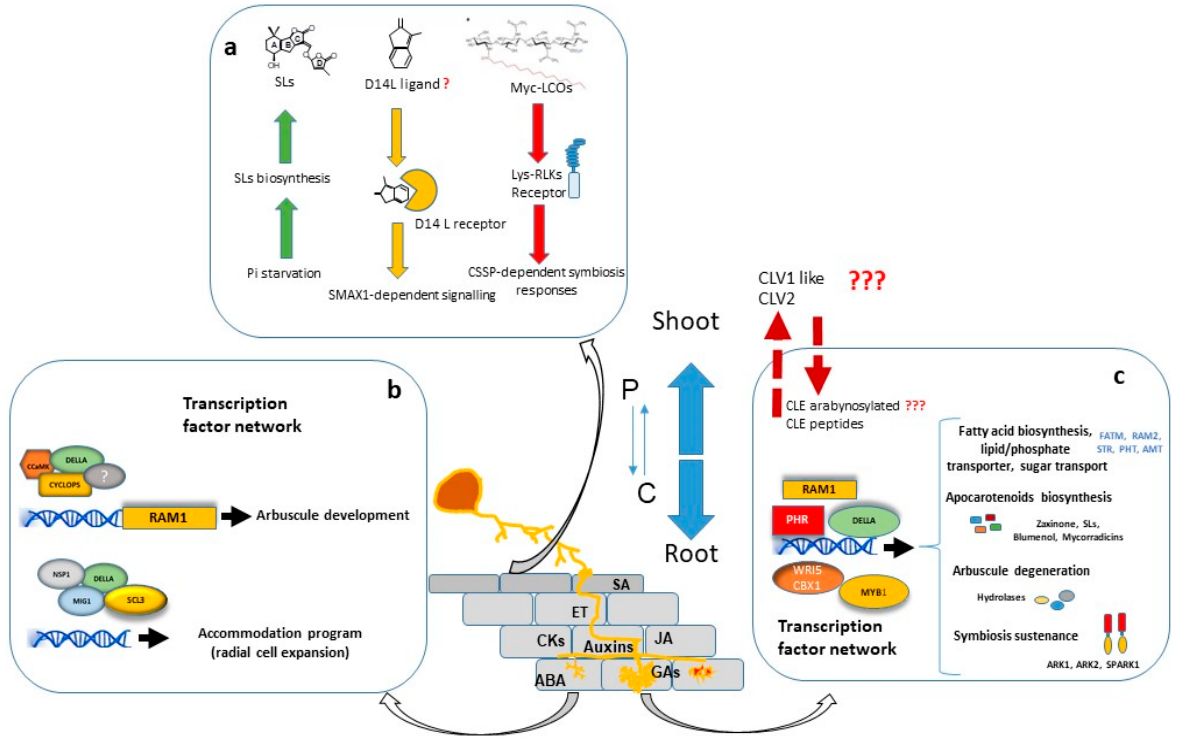
Figure 1. Development of the arbuscular mycorrhizal (AM) symbiosis and its molecular regulation at different stages. AM symbiosis facilitates mutual nutritional benefits: the plant provides carbon (C) to AM fungi in form of carbohydrates and fatty acids, while AM fungi provide minerals, mainly inorganic phosphate (Pi) and nitrogen to the plant. The availability of the different nutrients is a key factor determining the establishment and development of the interaction. AM symbiosis alters plant hormonal homeostasis, and phytohormones play a key regulatory role in the establishment and functioning of the AM symbiosis at different levels: regulating physiology and growth, as well as defense and stress adaptation in AM plants, and participating in the formation and turnover of AM structures. At initial stages ( a ), Strigolactones (SLs), secreted from host roots under Pi starvation, induce fungal spore germination and hyphal branching, facilitating the contact of the fungal hypha with the root and the formation of the hyphopodium. In response to AM perception, a complex of D14L receptor with a yet unknown D14L ligand is proposed to promote the degradation of SMAX1 and the downstream activation of target genes, including symbiosis-related and SL synthesis genes necessary for the accommodation of AM fungi in host cells. AM-released chitinaceous molecules (Myc-LCOs) are proposed to be detected by specific Lys-RLKs with the formation of a receptor complex that leads to the induction of the common symbiosis signaling pathway (CSSP)-dependent symbiosis responses, including transcriptional regulation of AM symbiosis-related genes, which promotes the successful colonization of host root cells by AM fungi. A number of CSSP-activated nuclear transcription factors including CCaMK and CYCLOPS form complexes with a large number of GRAS domain-containing transcription factors, including DELLA, MIG1 and SCL3 that enable the downstream activation of symbiotic genes that facilitate the morphological accommodation of the root cell hosting the fungus, and possibility arbuscule development through the activation of RAM1 ( b ). Arbuscule functionality, maintenance and turnover ( c ) are also dependent on a number of nuclear transcription factors such as PHR, RAM1, DELLA, MYB1 and WRI5A/B that regulate transcriptional programs related to biosynthesis and the transport of nutrients, and biosynthesis of apocarotenoids compounds with regulatory roles. PHRs integrate phosphate starvation signaling, regulating mechanisms for both direct uptake of soil phosphate and AM symbiosis. DELLA and MYB1 regulate arbuscule degradation through activation of genes involved in hydrolysis processes.